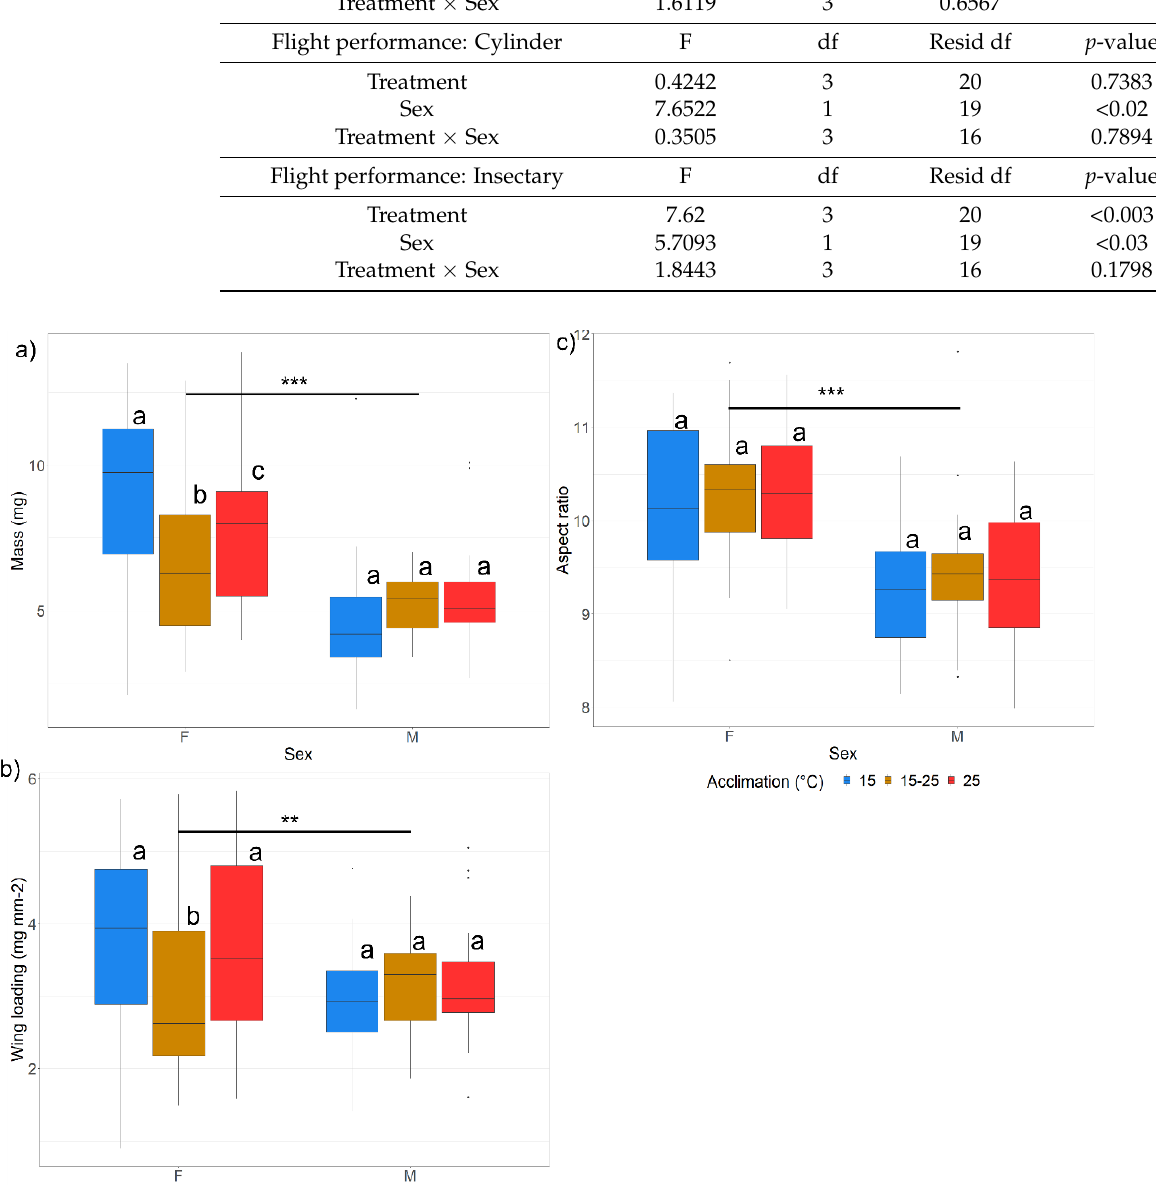
Figure 4. Boxplots indicating ( a ) mass (mg); ( b ) wing loading (mg mm − 2 ); ( c ) aspect ratio with their upper and lower quantiles and maximum and minimum values (whiskers) for adult males (M) and females (F) emerging at the three different acclimation temperatures (15 ◦ C, 15–25 ◦ C and 25 ◦ C). Significant differences between flight temperatures are indicated as: * = p < 0.05, ** = p < 0.001, *** = p < 0.0001, NS = not significant. Different letters indicate significant differences between acclimation per flight temperature.